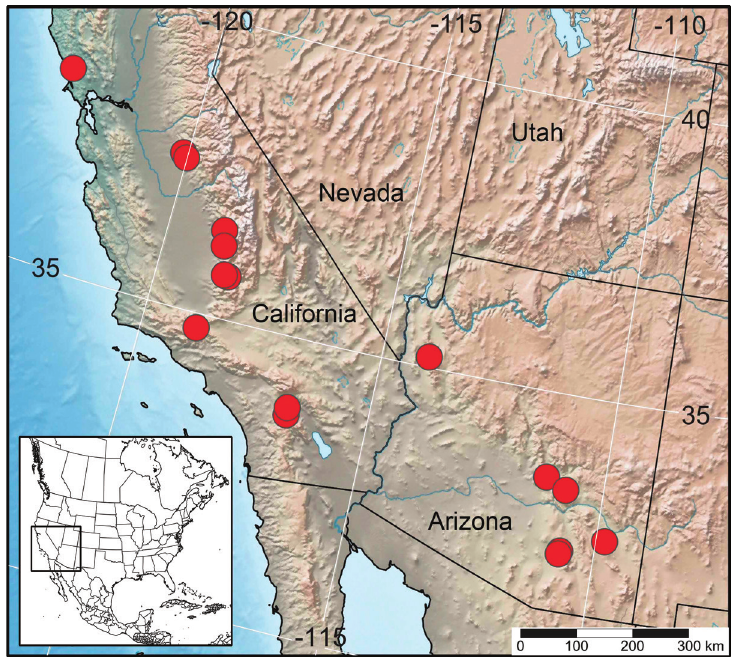
Figure 3. Distribution of Henryognathus thomasi in the American